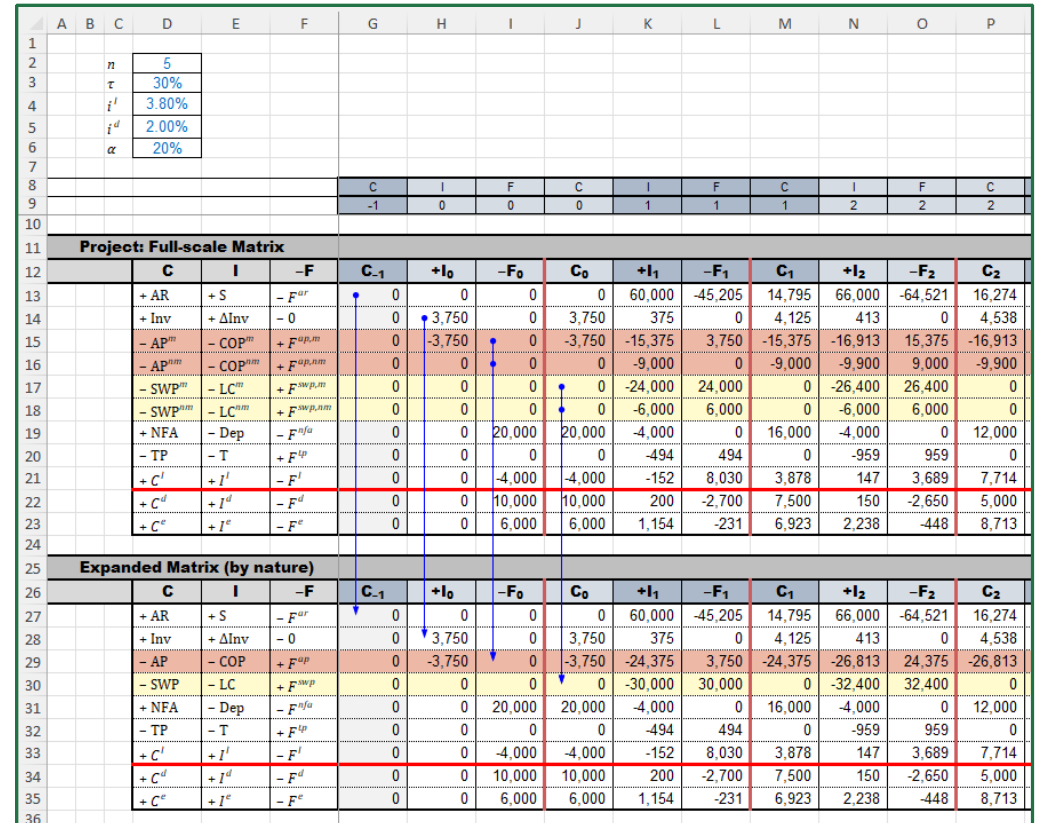
Figure 24. From full-scale matrix to expanded matrix by nature (see Part I, Equation (33)). The rows with the same color in the Full-Scale Matrix are consolidated into one row of the same color in the Expanded Matrix.